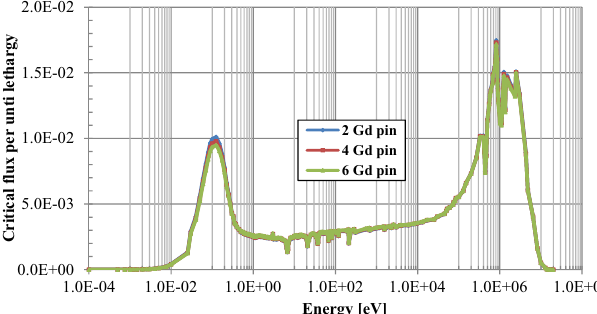
Fig. 4. Pro fi les of sensitivity per unit of lethargy about 157 Gd (n, g ) cross section as a function of incident neutron energy for the GE10 (cid:3) 10-8 FA; the two curves refer to different moderator densities.